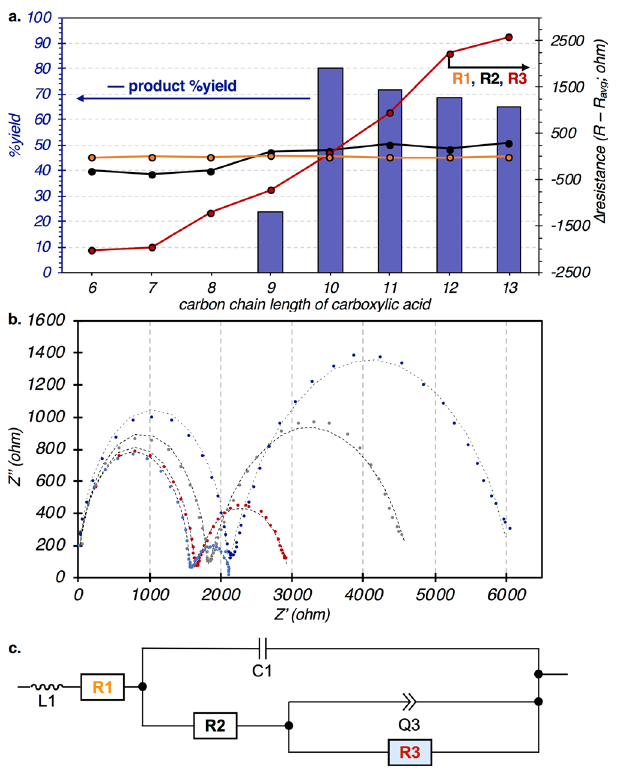
Fig. 3 Structure-Reactivity Studies of Carboxylic Acids. a Comparison of the yield of 1 (left axis, bars) and independent resistors from EIS fi ttings (right axis, trace) as a function of varying chain lengths. b . Nyquist plots from EIS and modeled fi t (dashed traces) of C6, C8, C10, and C12 after 30 min of electrolysis. c Illustration of the equivalent circuit employed to fi t the EIS